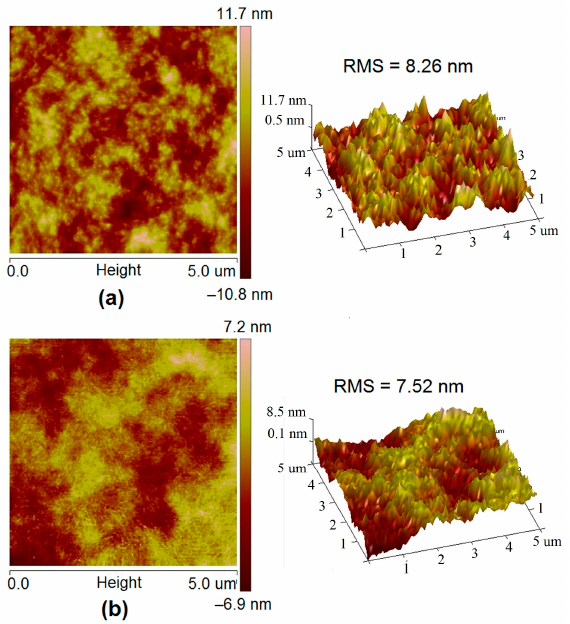
Figure 6. Atomic force microscopy (AFM) height images of PBDTS-ID:PC 71 BM ( a ) and PBDTS-DTNT:PC 71 BM ( b ) blend films with 3% DIO additive treatment.